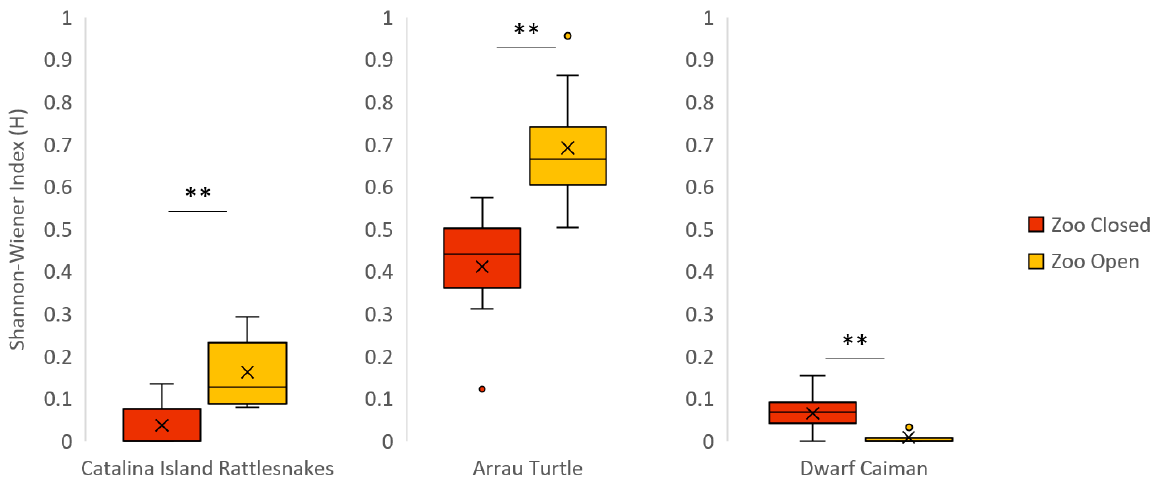
Figure 1. Boxplot for all significant differences within a species in the Shannon–Wiener Index (H) when the zoo was closed vs. open. For H, lower values indicate a lower variety of behaviors. The mean of each condition is represented by an “ × ”. Significant differences of Pr > |S-Mean| equal to 0.01 or below are indicated with a double asterisk (**).